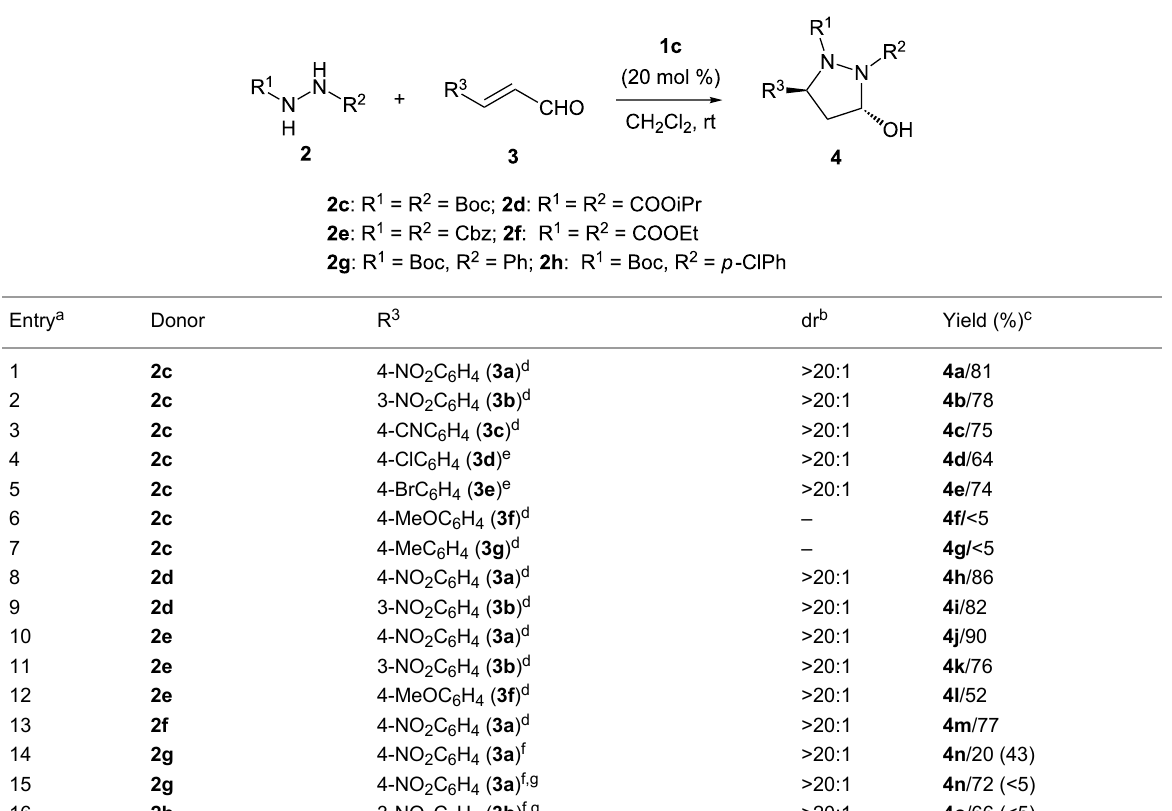
Table 2: Substrate scope for the cascade aza-Michael/hemiacetal reactions between 2 and α , β -unsaturated aldehydes 3 .